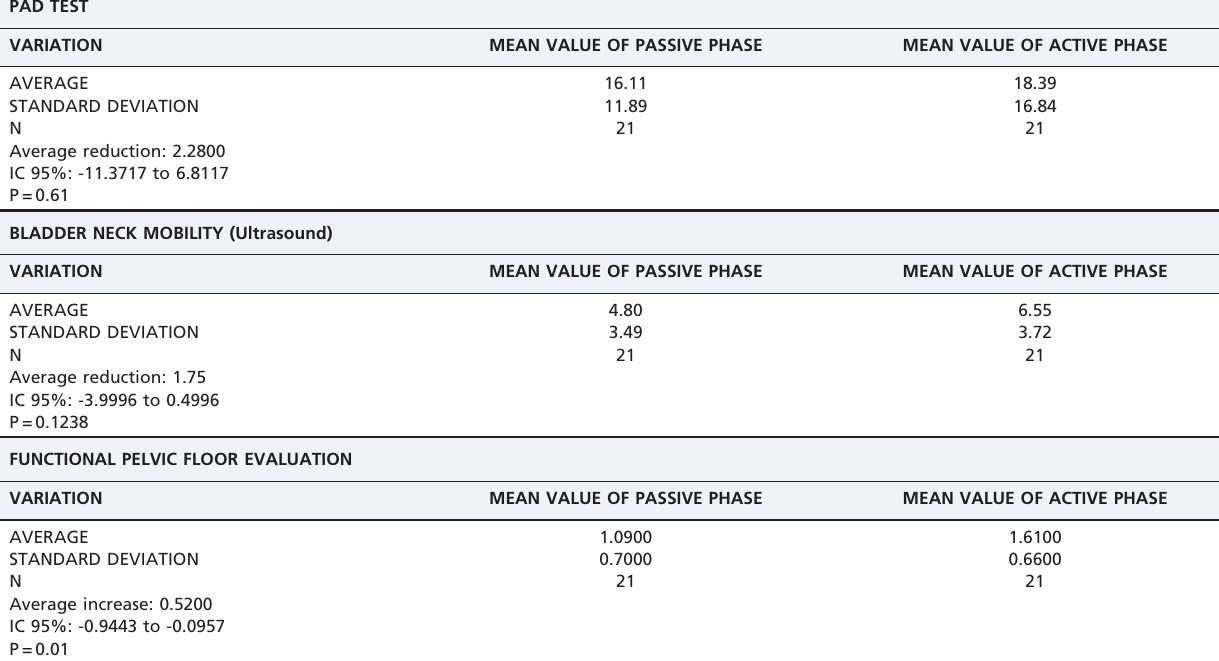
Table 3 - Comparison of the variation in the mean value of the passive-phase endpoint and baseline with that of the variation in the mean value of the active-phase endpoint and baseline: pad test, bladder neck mobility, and functional pelvic floor